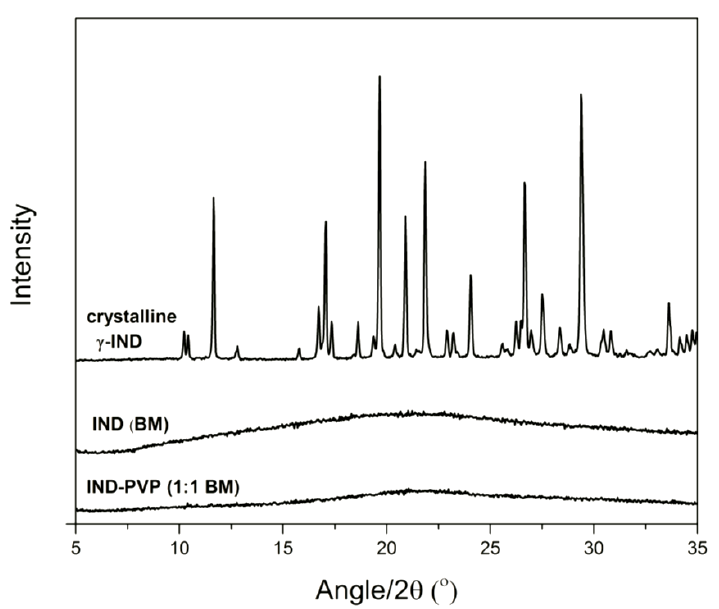
Figure 1. X-ray powder diffraction (XRPD) diffractograms of crystalline starting material (crystalline γ-IND), amorphous indomethacin (IND) and IND–poly(vinylpyrrolidone) (PVP) glass solution (1:1 w / w ) after ball milling